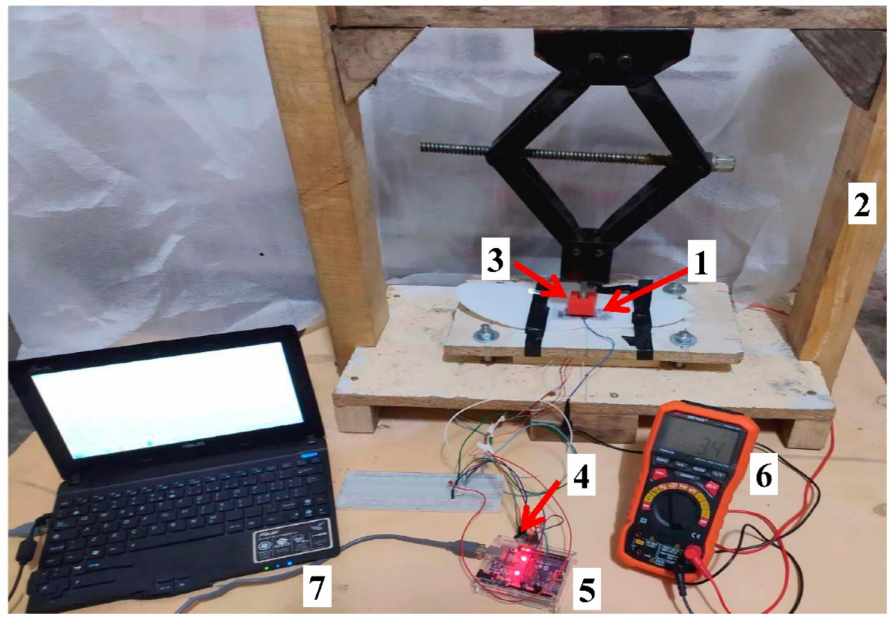
Figure 16. Experimental setup employed for the characterization of the Velostat-based piezoresistive sensors, with highlighted the main